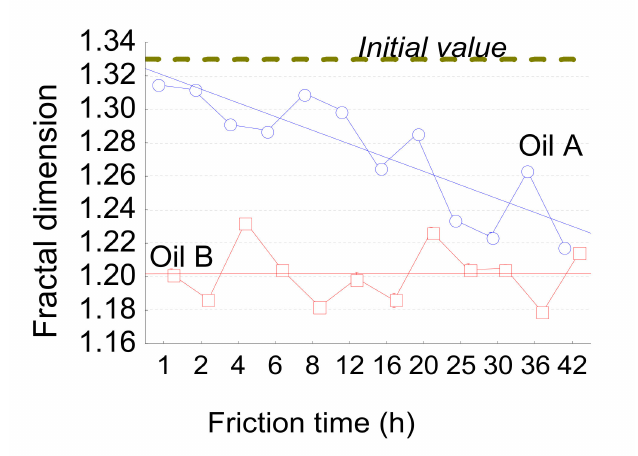
Figure 17. Number of peaks per inch evolution versus the friction time for both oils (A and B).